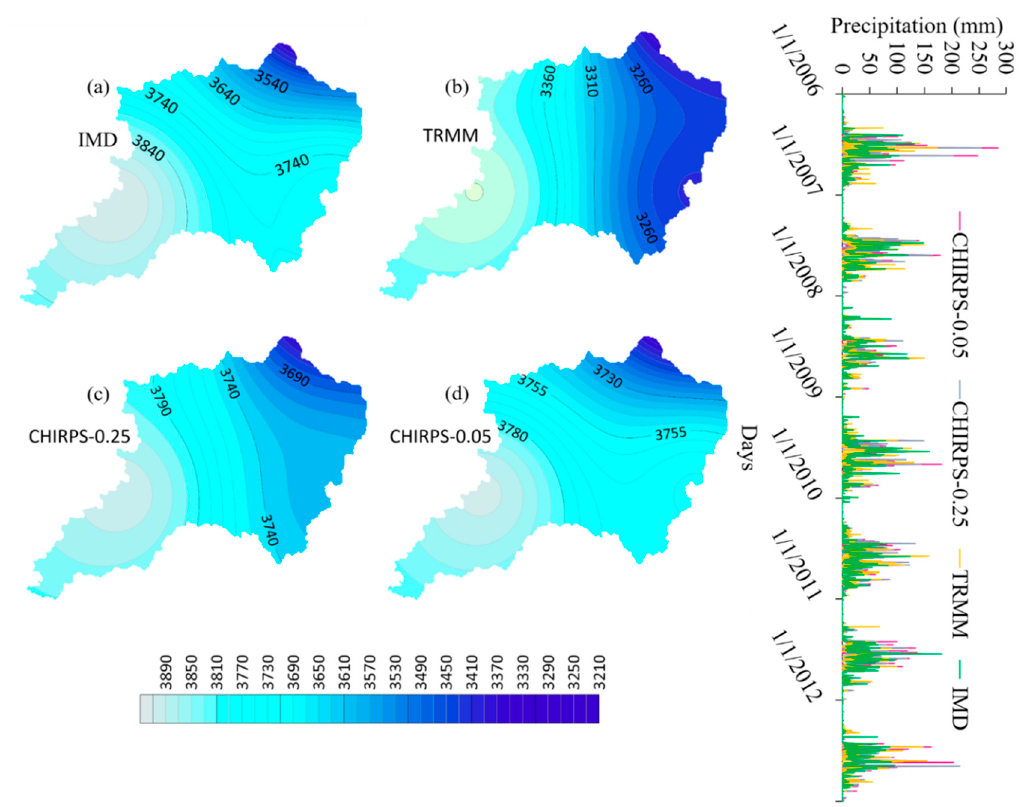
Figure 3. Spatial distribution and time series plot of ( a ) IMD ( b ) TRMM ( c ) CHIRPS-0.25 ( d ) CHIRPS-0.05 rainfall datasets.